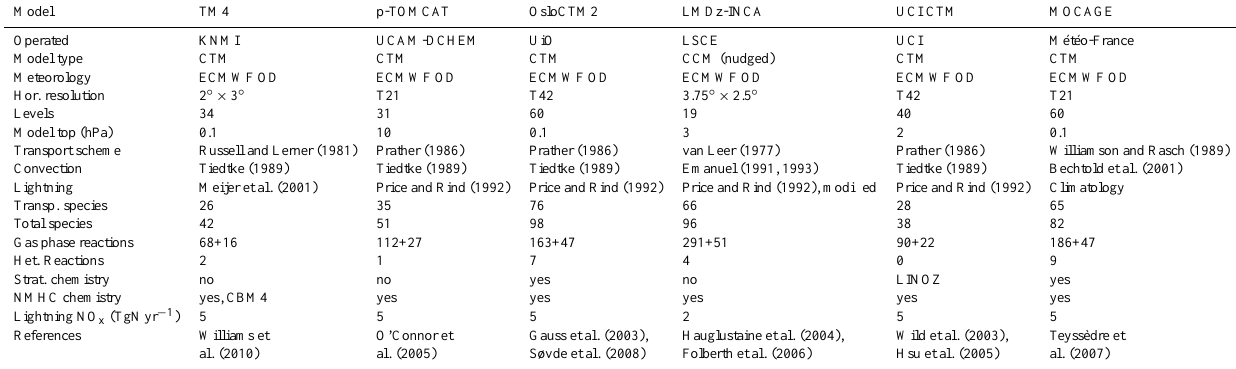
Table 2. Specifications of the participating models in this study (modified from Hoor et al.,